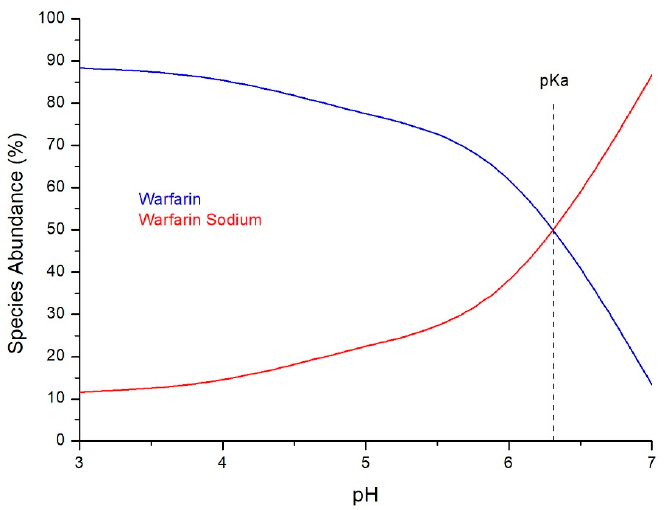
Figure 10. Abundance of warfarin and warfarin sodium in the pH range of 3–7.